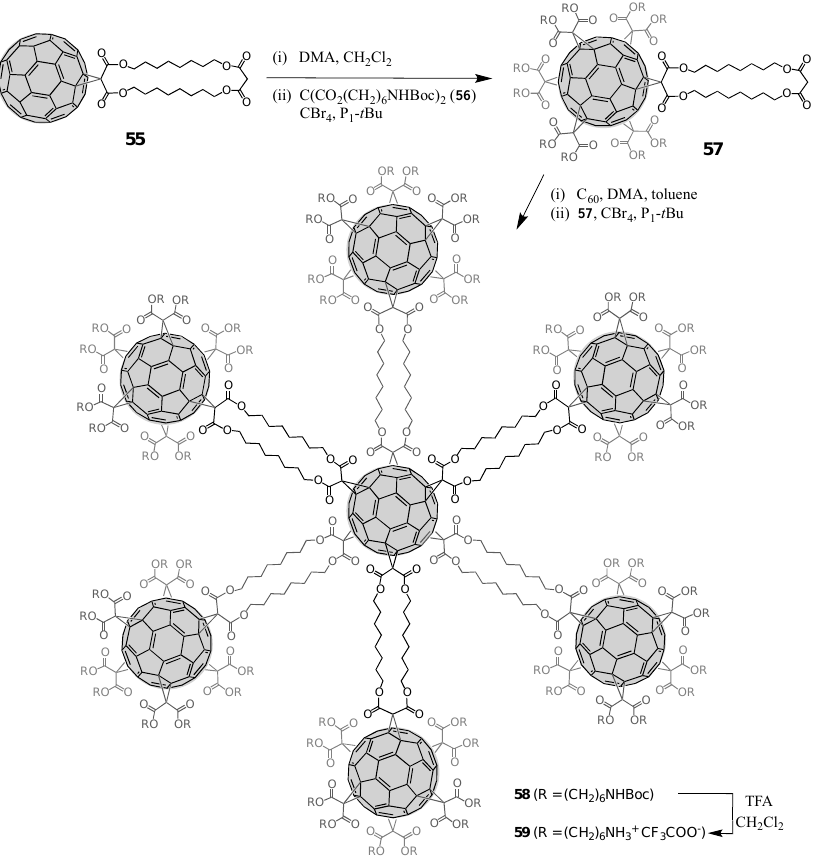
Scheme IX. Synthesis of star-shaped heptafullerene polyelectrolyte 59